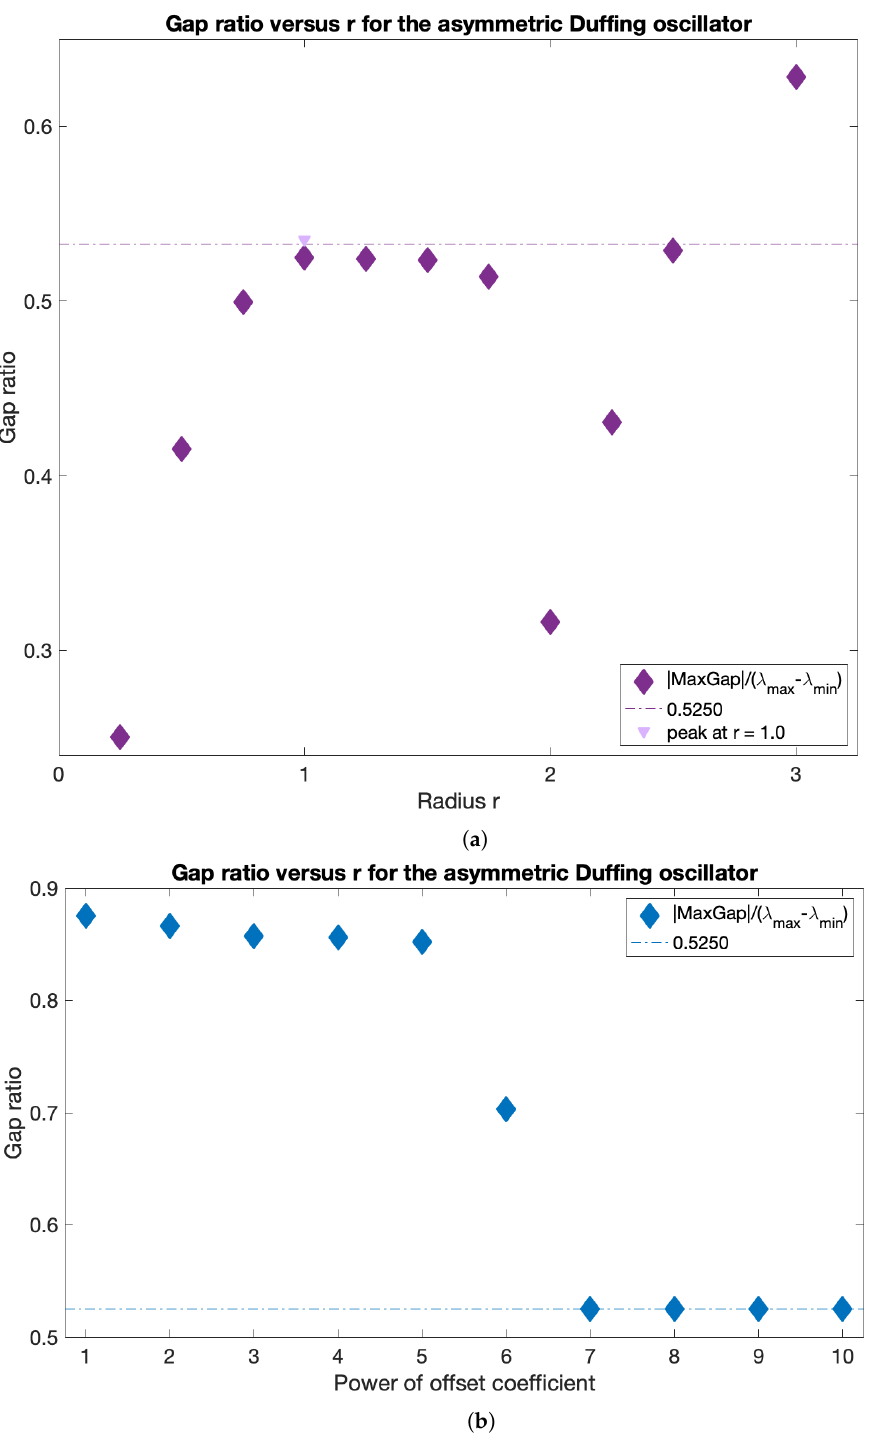
Figure A2. Steps 1 and 2 of the spectral clustering protocol for the asymmetric Duffing oscillator. ( a ) Sweep of r parameters with offset coefficient 10 7 for the average distance function. ( b ) Sweep of offset coefficients 10 n for average distance function and the normalized eigengap peak at r =